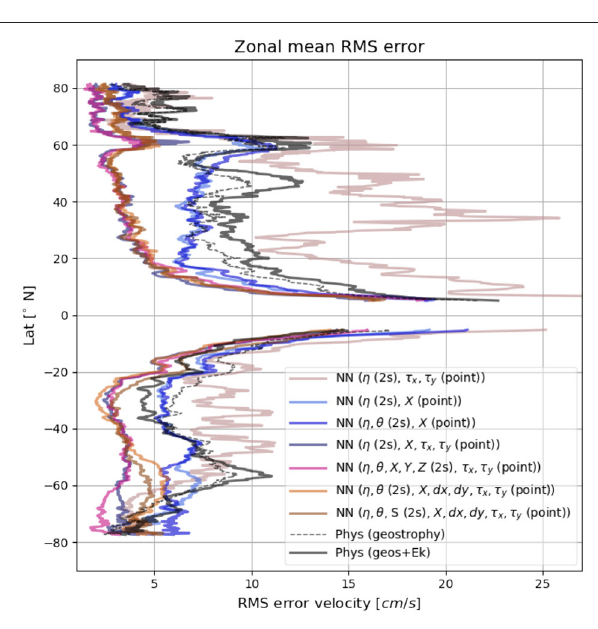
FIGURE 9 | Comparison of the zonal mean rms errors for the various NN predictions shown alongside the physical model (with and without Ekman